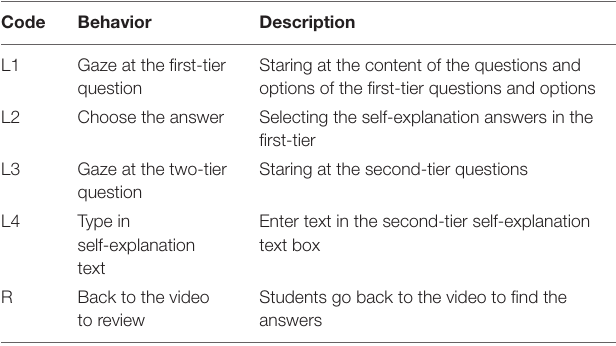
TABLE 1 | Two-tier self-explanation behavior coding